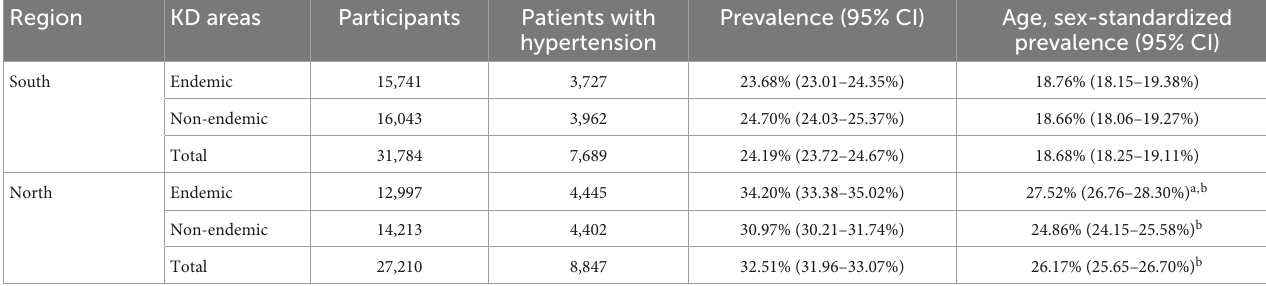
TABLE 3 Prevalence of hypertension in KD-endemic and non-endemic areas in the southern and northern regions of China. Region